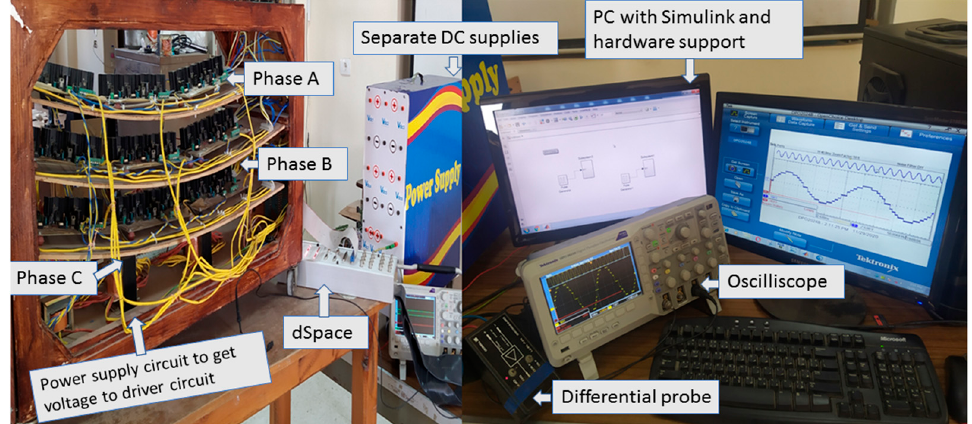
( b ) Figure 10. ( a ) Switching angles versus modulation index. ( b ) Harmonics order of fifth and seventh in % of fundamental versus modulation index. 7. Hardware Setup and Experimental Results for Seven-Level Inverter The simulation results obtained from the proposed MPA algorithm are verified through the scaled-down prototype in the laboratory. A seven-level cascaded H-bridge three-phase inverter shown in Figure 11 was constructed using IRFP460 MOSFET (Intersil Corporation, Milpitas, CA, USA) (500 V, 20 A) power switch transistor. Three H-bridges in each phase have identical separate DC voltage sources of 36 V. In addition, 50 Hz is the